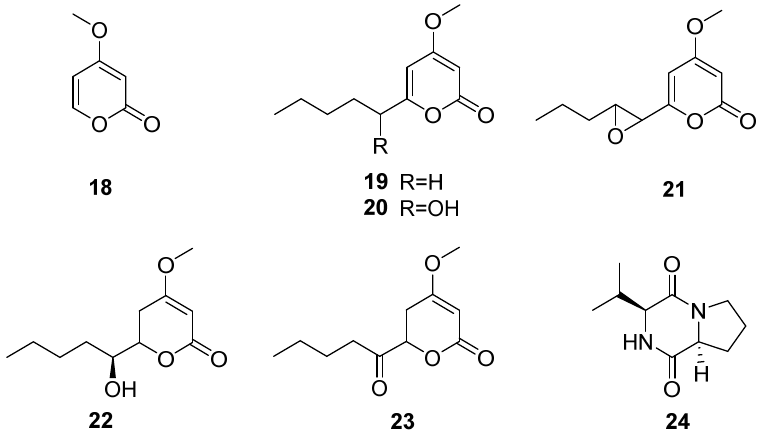
Figure 7. Structure of lactones 18 – 23 and cyclic dipeptide 24 [22].